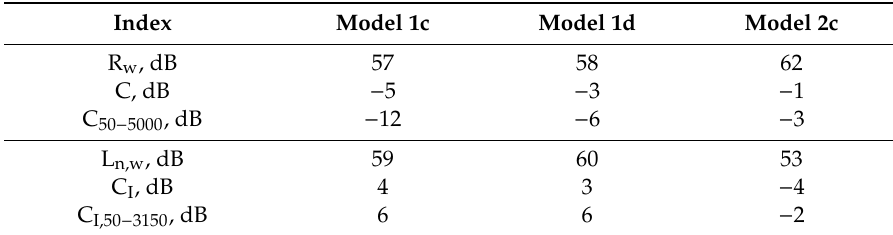
Table 7. Single-number quantities of the selected floor structures.